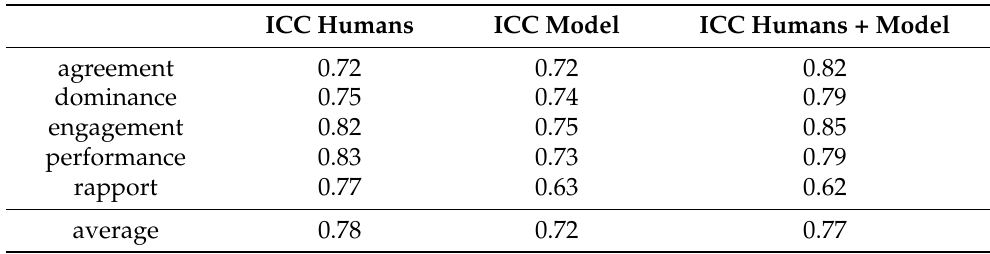
Table 4. Intra-class correlation (ICC) measuring agreement between 6 human raters (ICC Humans), 6 raters sampled from the outcome model (ICC Model) and the 12 human + model simulated raters ( p < 0.05 for all